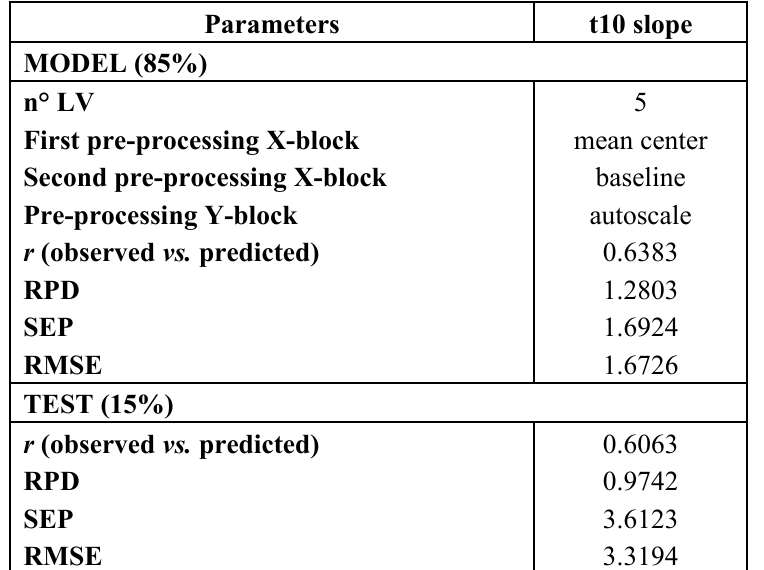
Table 4. Results of Partial Least Squares (PLS) for the prediction of SWC obtained with thermometric analysis performed in field for the interval t slope. In the table are reported: 10 n° of Latent Vectors (LV); first and second pre-processing for the X-block and one for the Y-block; the correlation coefficient ( r ); the Ratio of Percentage Deviation (RPD); the Standard Error of Prevision (SEP) and the Root Mean Square Error (RMSE) for the model and test.